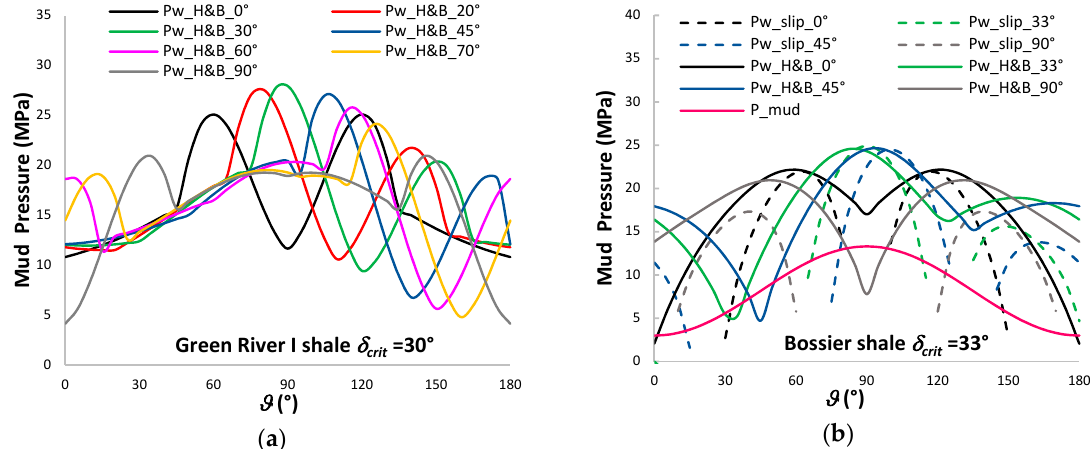
Figure 14. ( a ) Mud pressures calculated with the Hoek and Brown criterion, at different δ . In situ stresses: σ MAX = 70 MPa, σ min = 50 MPa, P f = 45 MPa ( b ) Comparison between the mud pressures calculated with the weakness plane model, Hoek and Brown criterion and Mohr Coulomb criterion (P_mud). In situ stresses: σ MAX = 45 MPa, σ min = 35 MPa, P f = 20 MPa.